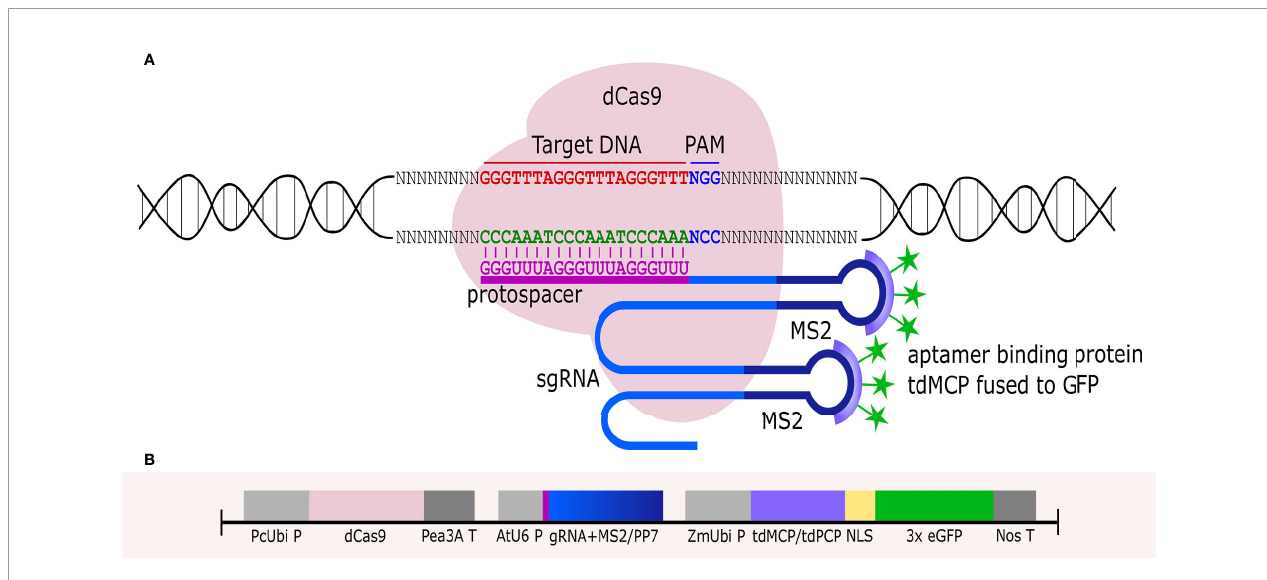
FIGURE 1 | RNA aptamer-based CRISPR/dCas9 imaging of telomere repeats. (A) Schemata depicting the components of the aptamer-based CRISPR labeling method: (1) dCas9 from S. pyogenes , (2) MS2 or PP7 aptamers (here only MS2 is shown) which are integrated into the sgRNA scaffold. (3) RNA binding protein (tdMCP or tdPCP) fused to fl uorescent protein (3x eGFP) which recognizes aptamers. Protospacer designed to target Arabidopsis -type telomere DNA sequence. (B) Structure of the aptamer-based CRISPR imaging construct. dCas9 is driven by a ubiquitin promoter from parsley (PcUbi P), chimeric gRNA including aptamers (MS2/PP7) are driven by the AtU6 promoter (AtU6 P), aptamer binding proteins fused to a fl uorescent protein (tdMCP/tdPCP) with the help of nuclear localization signal (NLS) are driven by a ubiquitin promoter from maize (ZmUbi P). Pea3A T and Nos T were used as